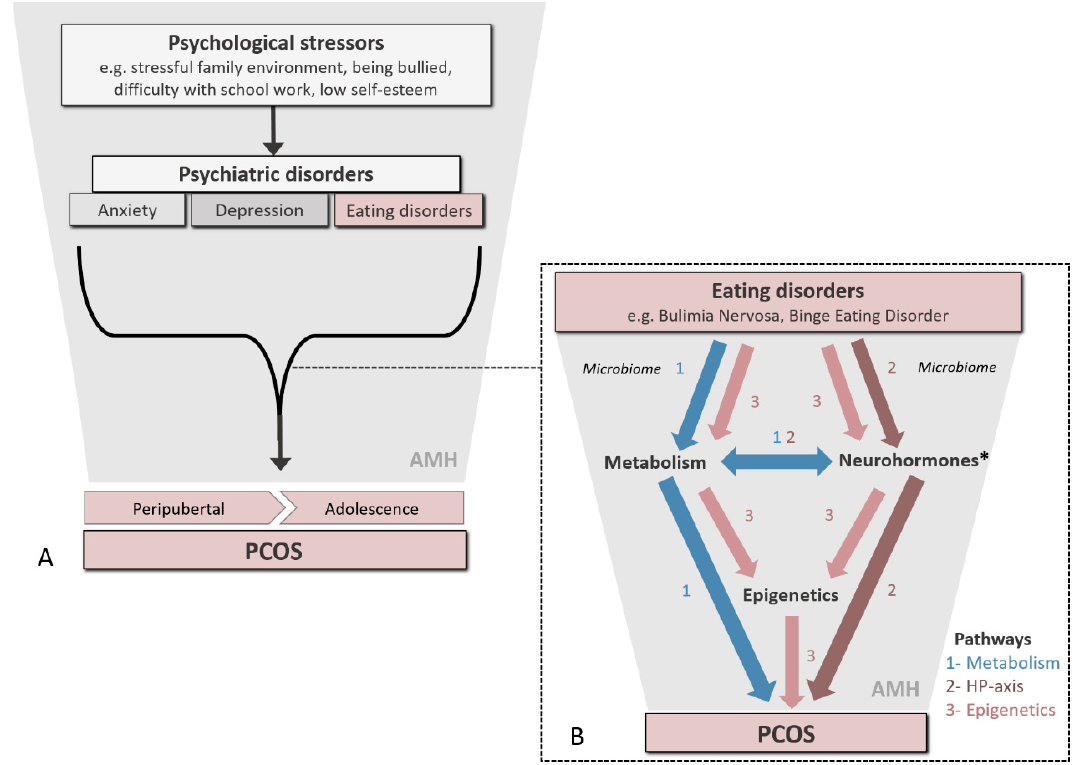
Figure 2. ( A ) Novel hypothesis for the role of psychological stressors and eating disorders in the induction of PCOS during the peripubertal and adolescent periods, emphasizing the importance of anti-Müllerian hormone (AMH) as an underlying factor. ( B ) Physiological pathways by which eating disorders during this critical period of development can contribute to the induction of PCOS. * Estradiol, AMH, leptin, insulin and